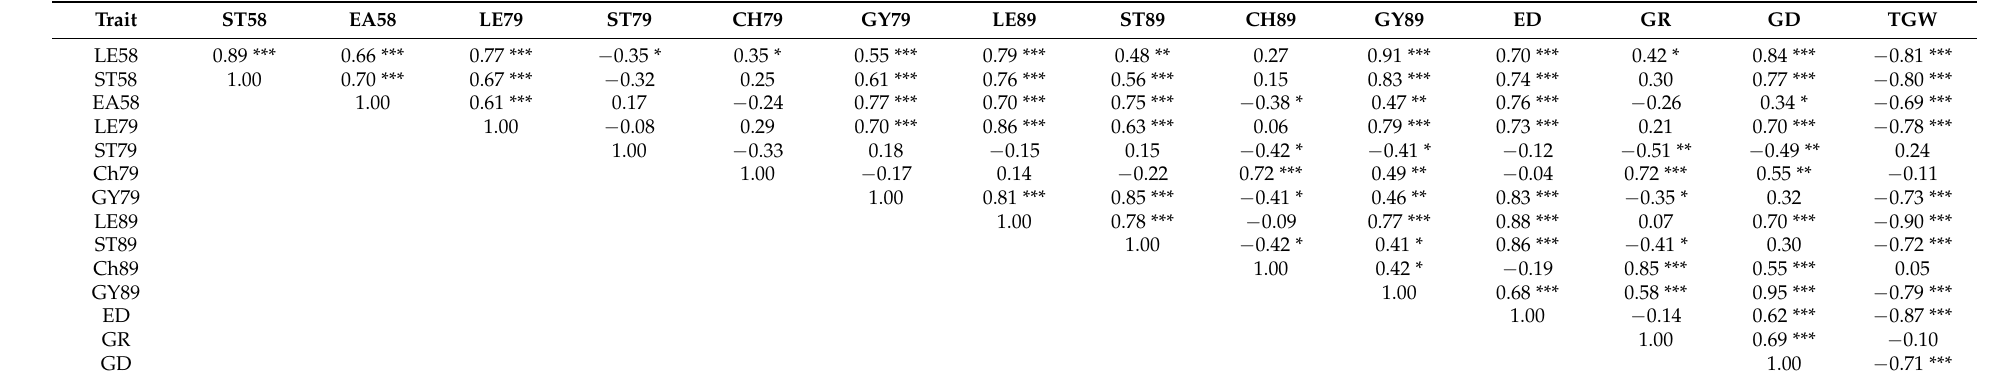
Table A1. Matrix of correlation indices for winter wheat biomass components, n = 36.